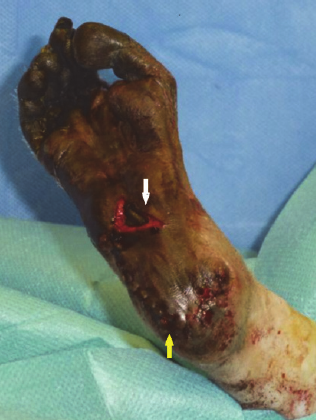
Figure 3: Pedicled instep flap (yellow arrow), donor site covered by countertransplantation of a full thickness graft from the interdigital webspace in between the digiti pedis I and digiti pedis II of the ipsilateral foot (white arrow).